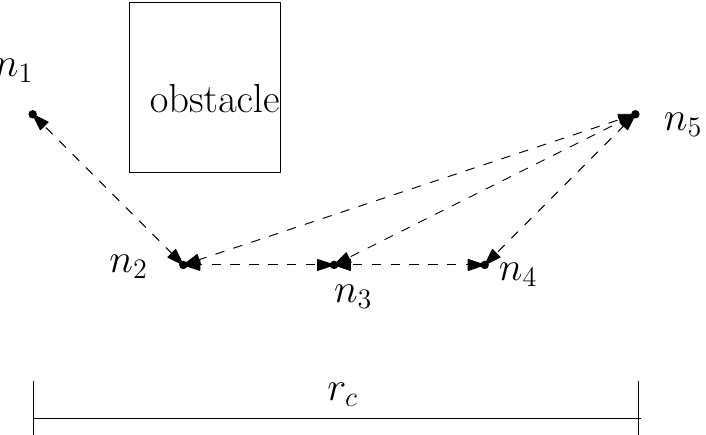
Figure 1. I consists of five vertices n 1 , n 2 , n 3 , n 4 , n 5 . There exists a rectangular obstacle. Each directed edge in I is plotted with dashed directed line segments. Each edge length is shorter than r c , and every directed edge is an obstacle-free